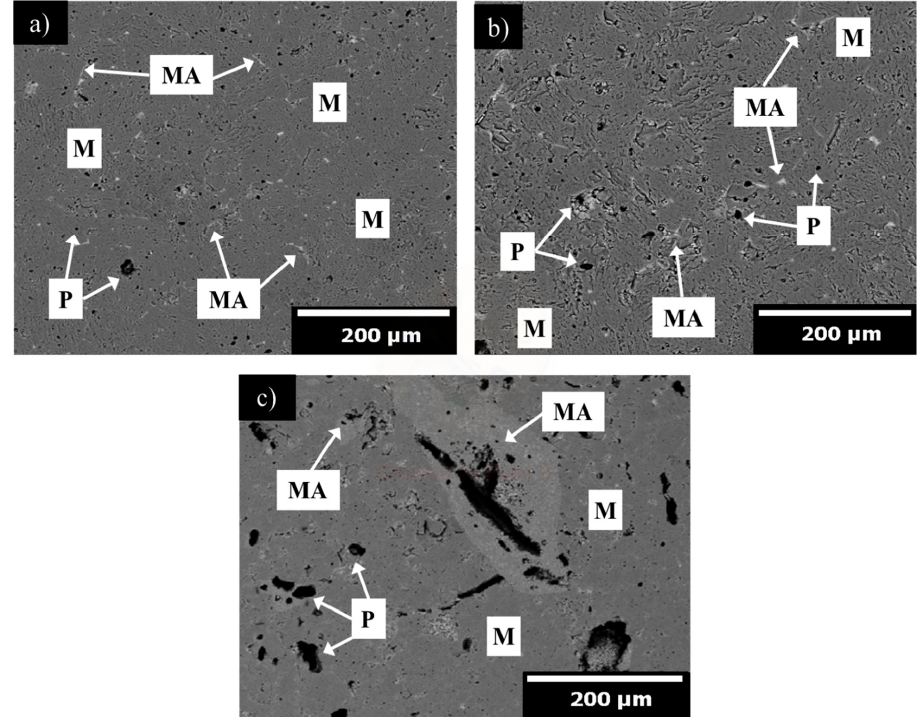
Figure 8. SEM micrograph of microstructural evolution of magnesia samples with increasing addition of α -Al 2 O 3 nanoparticles, sintered at 1600 °C. ( a ) 1, ( b ) 3, and ( c ) 5 wt.%. M = magnesia, P = pores, and of α -Al 2 O 3 nanoparticles, sintered at 1600 ◦ C. ( a ) 1, ( b ) 3, and ( c ) 5 wt.%. M = magnesia, P = pores, MA = MgAl 2 O 4 spinel. and MA = MgAl 2 O 4